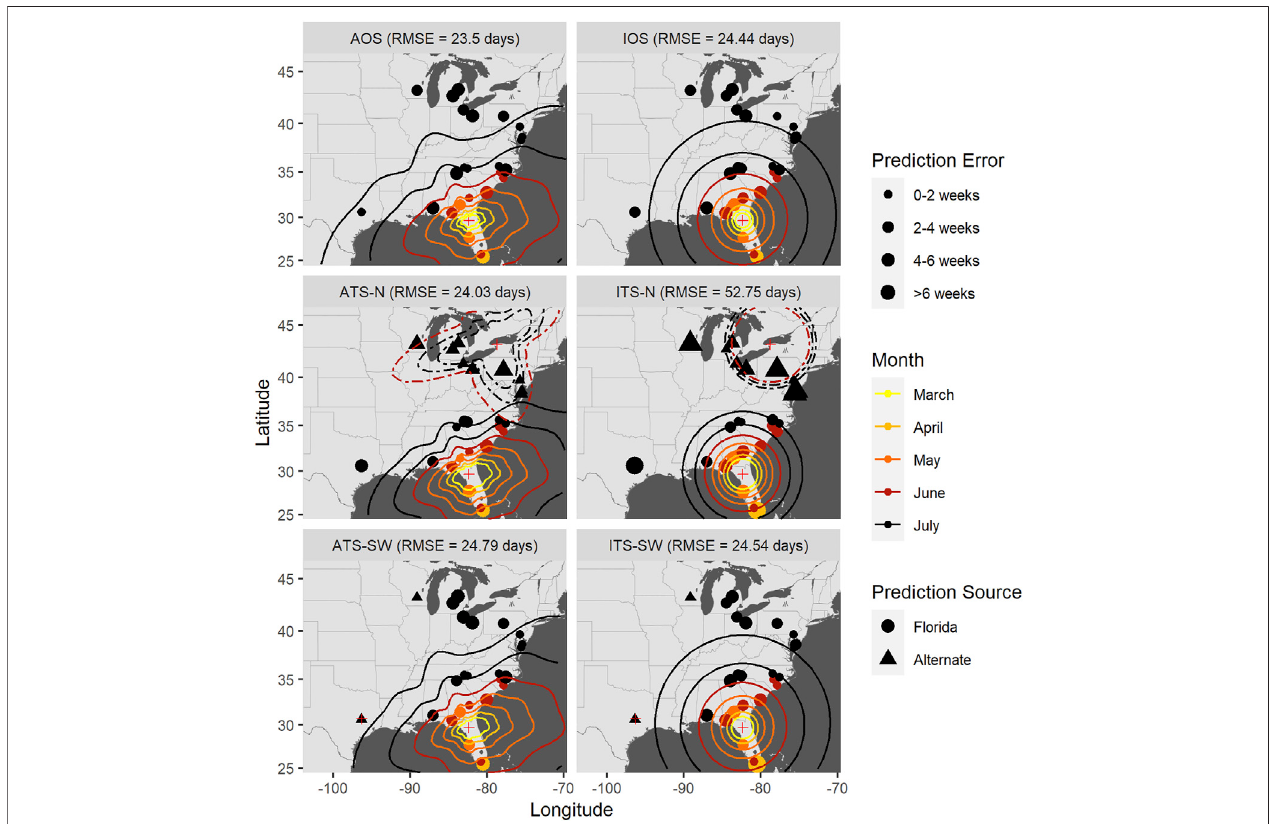
FIGURE9| Time-of-occurrencepredictionerrorsforpredictionsfrom isotropicandanisotropicone-andtwo-sourcemodels fi ttodatafromsentinel plotsin2010, withcontoursrepresentingestimateddiseasefrontovertimeaccordingtothemodels.Thetwo-sourcemodelswereeach fi twithtwoalternate(non-FL)sourcelocations: anorthernandasouthwesternlocation.Eachpanelshowsresultsaccordingtoadifferentmodel:isotropicone-source(IOS);isotropictwo-source(ITS);anisotropicone- source (AOS); and anisotropic two-source (ATS).